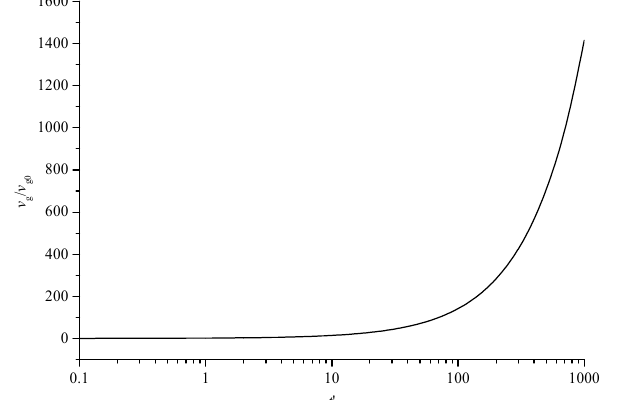
Figure 7. The total number of dimensionless sulfur particles varies with dimensionless time.